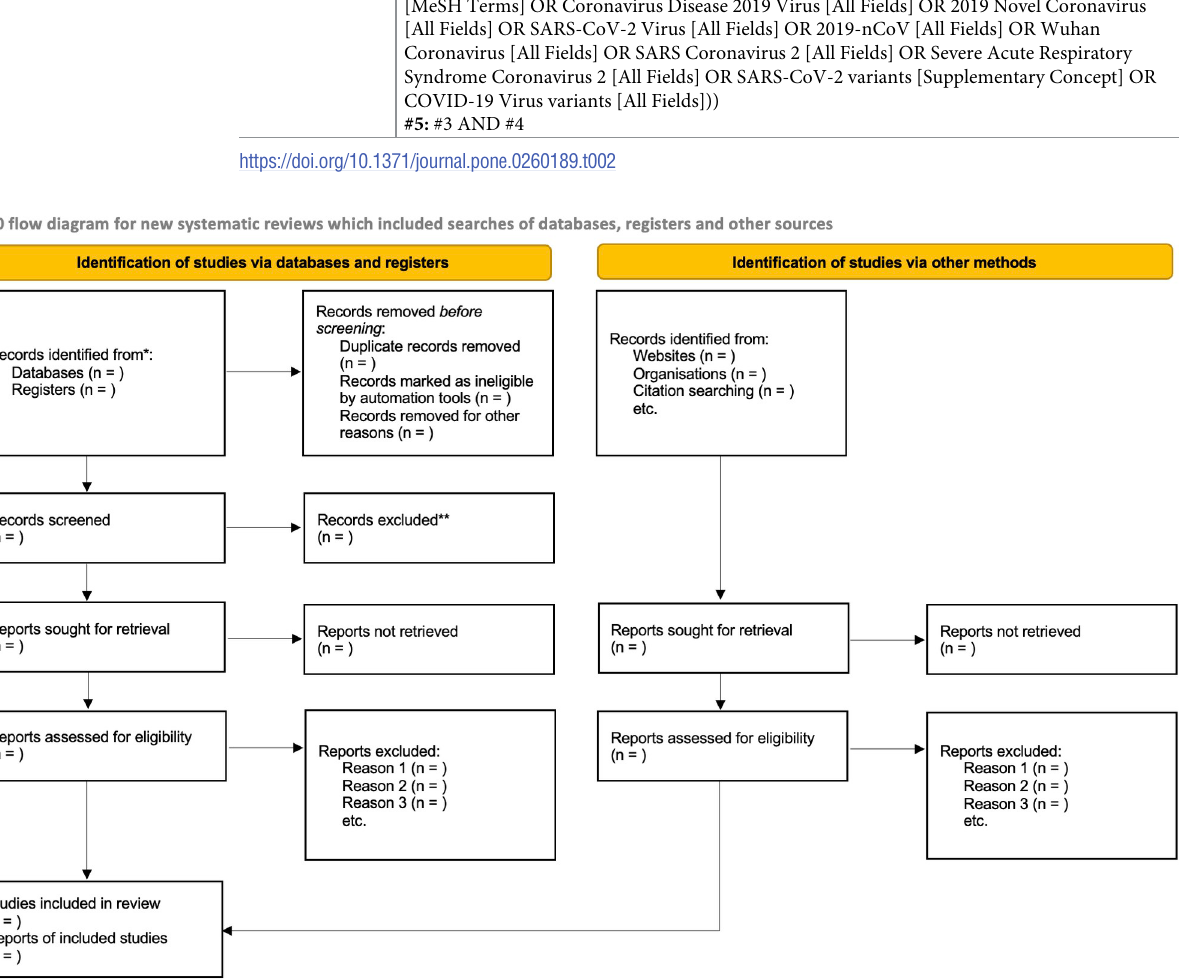
PLOS ONE | https://doi.org/10.1371/journal.pone.0260189 November17,